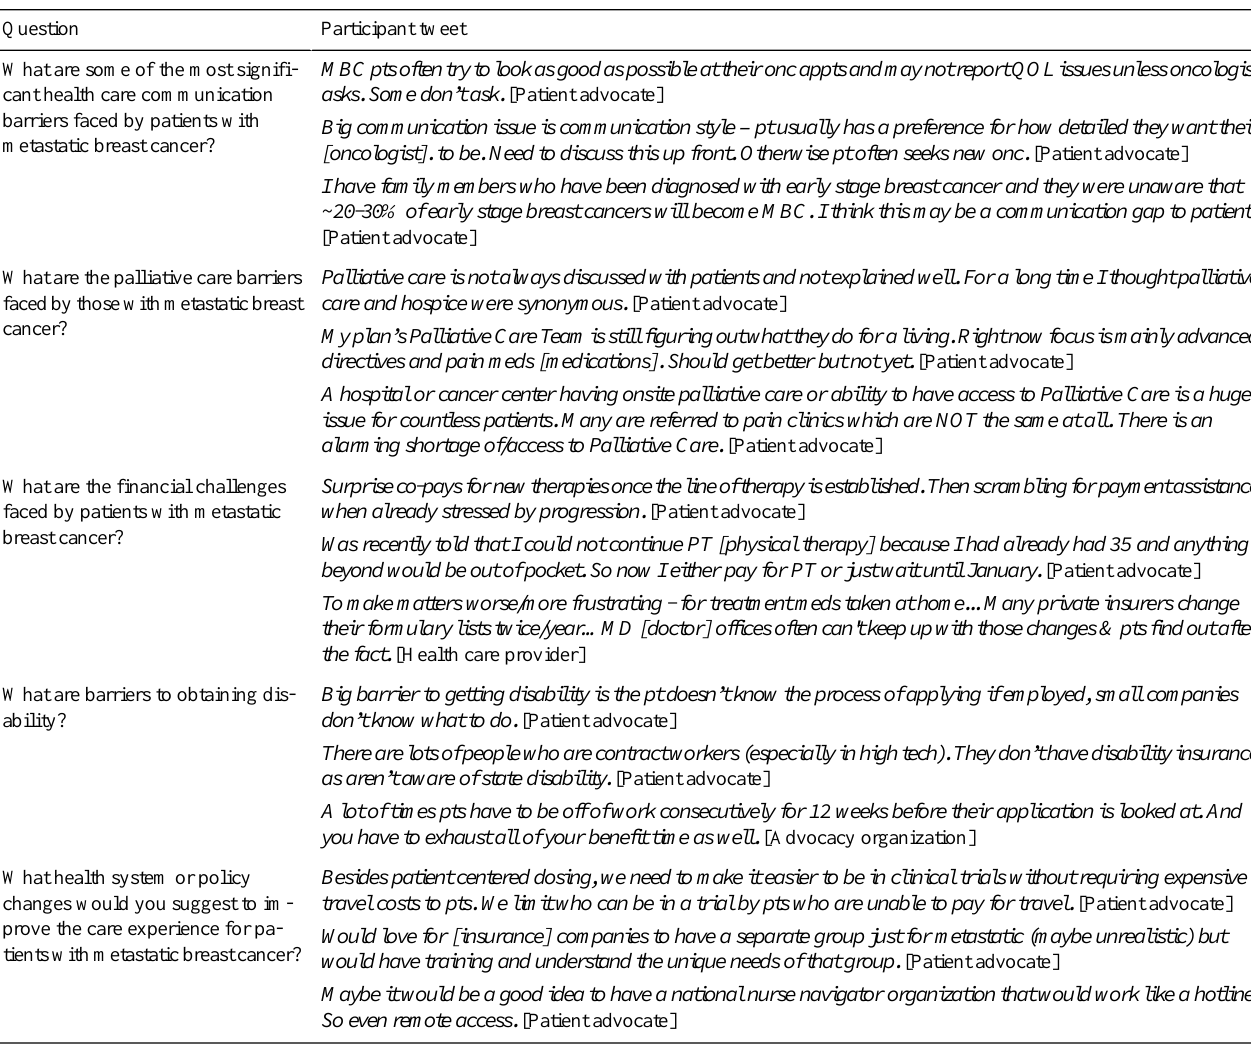
Table 2. Questions and representative responses from participants regarding barriers to care for metastatic breast cancer and potential policy solutions. Participant